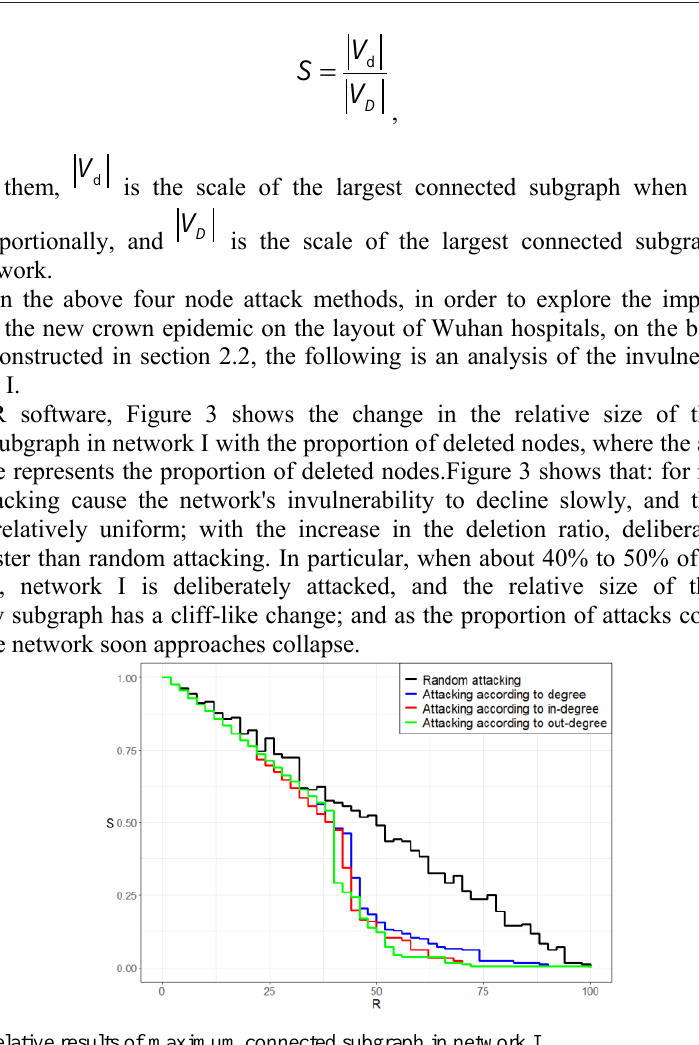
Fig. 3. The relative results of maximum connected subgraph in network